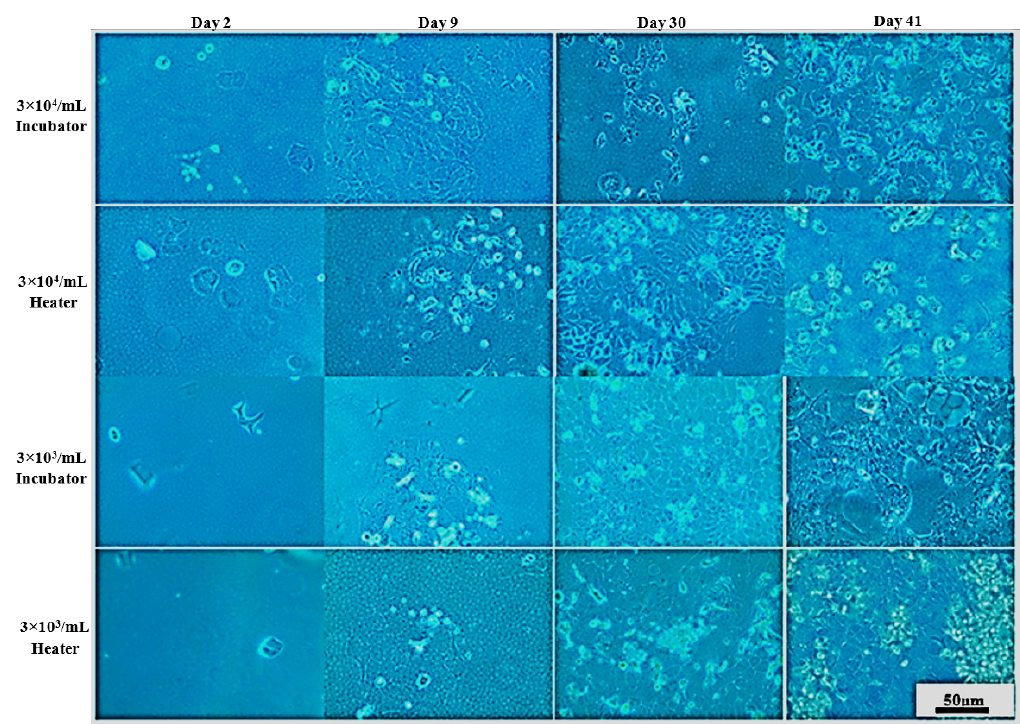
Figure 9. Representative images showing RT-112 cells morphology seeded on LOC platform at given conditions after indicated days of incubation. Incubator 37 °C, 5% CO 2 (standard growth conditions); heater 37 °C.